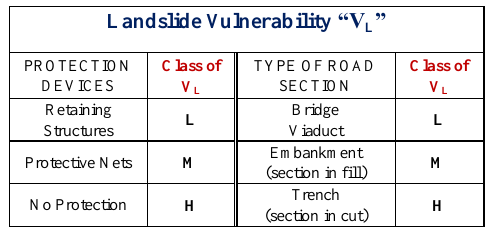
Table 3. Classification of road vulnerability to water invasion